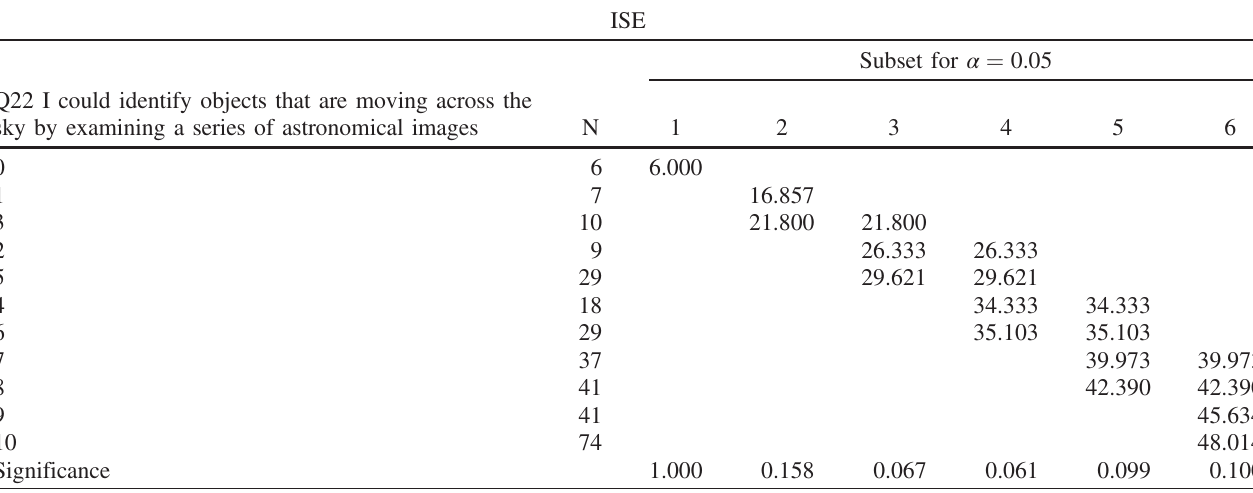
TABLE VI. Multiple comparisons using SNK for homogeneous subgroups of ISE based on the item indicated. Note that means for groups in homogeneous subsets are displayed.